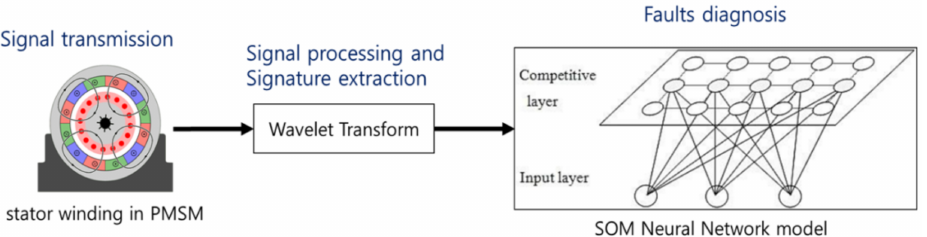
Figure 2. Process of diagnosis health and stator winding fault in Permanent Magnet Synchronous Motor